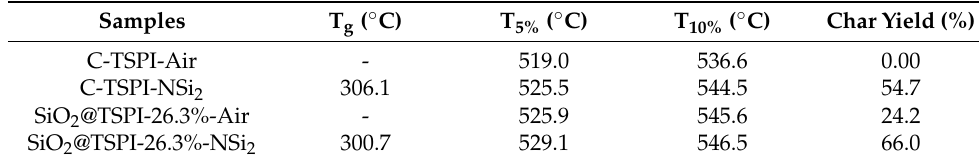
Figure 9. ( a , b ) Thermal performance of TSPI and printed SiO 2 @TSPI composites in air and nitrogen atmosphere; ( c ) DSC curves of TSPI and printed SiO 2 @TSPI composites. Table 2 . Data of thermal performance .